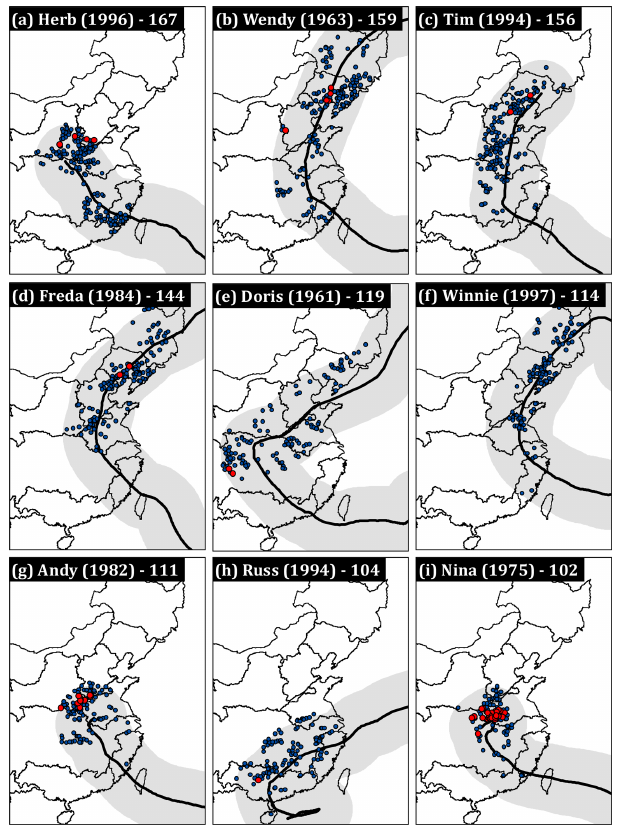
Figure 11. Tropical cyclones that produced more than 100 an- nual flood peaks (blue dots) over China. Red dots highlight that the annual flood peak is also the record flood of the station. Dark- black line shows tropical-cyclone track. Grey shading represents the 500km buffer zone of each track. See Table 1 for more